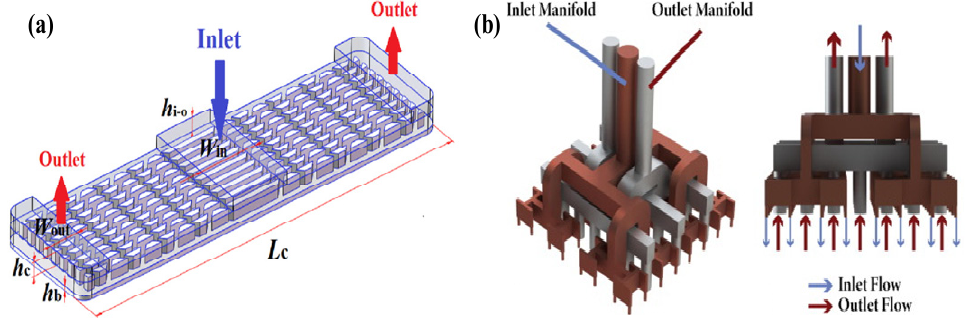
Figure 21. Schematic diagram of complex manifold hybrid microchannel:, ( a ) Yang et al. (adapted from Ref. [137]), ( b ) Paniagua-Guerra et al. (adapted from Ref. [138]).